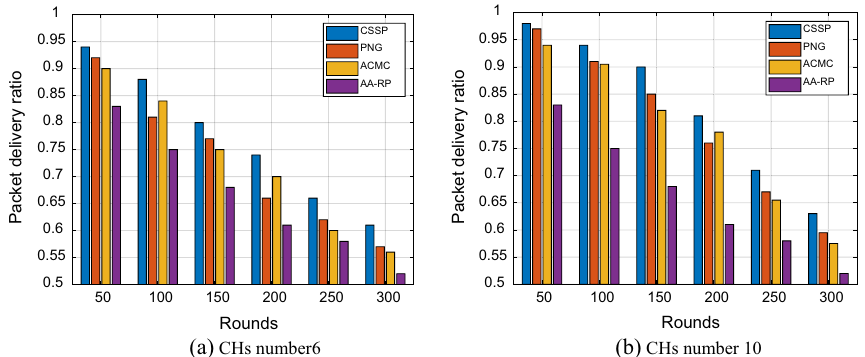
Fig. 8 Comparison of packet delivery ratio for different number of CHs (a) CHs number 6; (b) CHs number